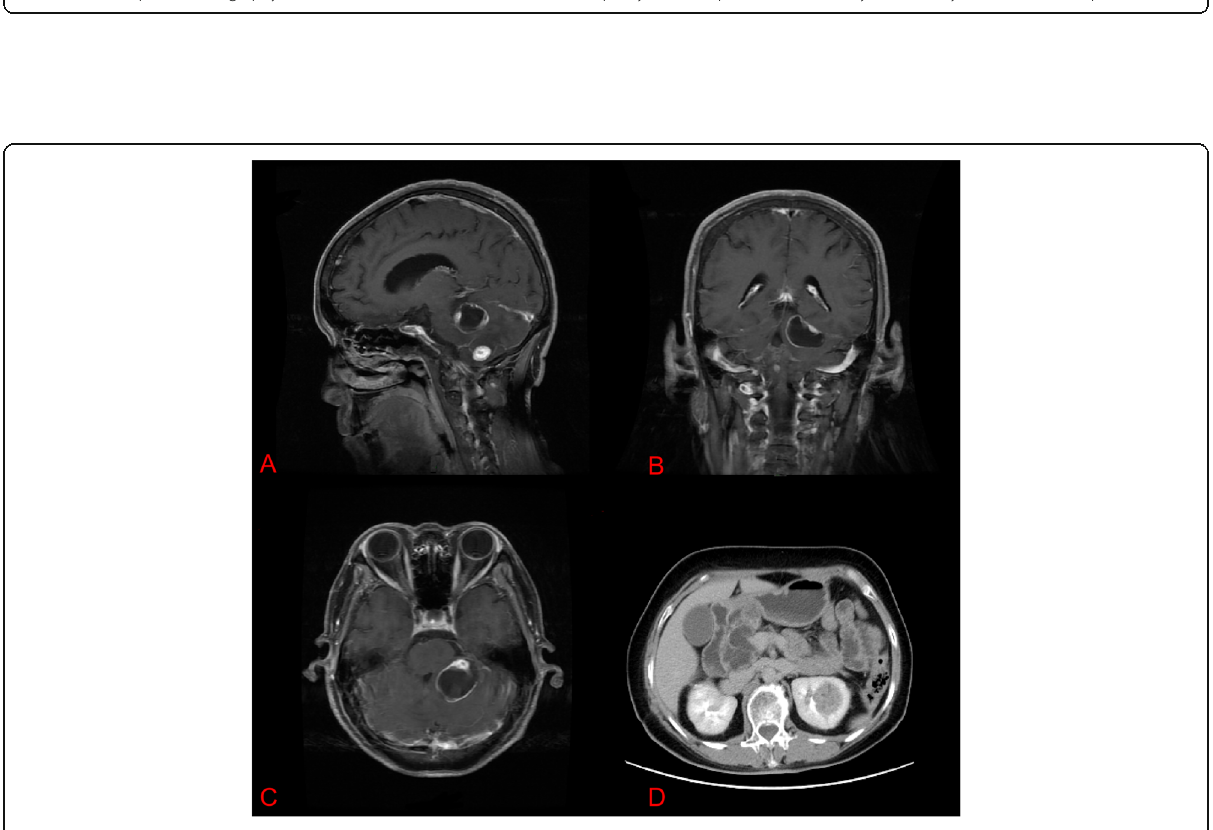
Fig. 1 a – c Contrast-enhanced magnetic resonance imaging (MRI) of the cerebellum hemangioblastomas in the 40-year-old male patient with VHL. d. Abdominal computed tomography (CT) scan with contrast demonstrated multiple cysts in the pancreas and kidneys in the 40-year-old male VHL patient